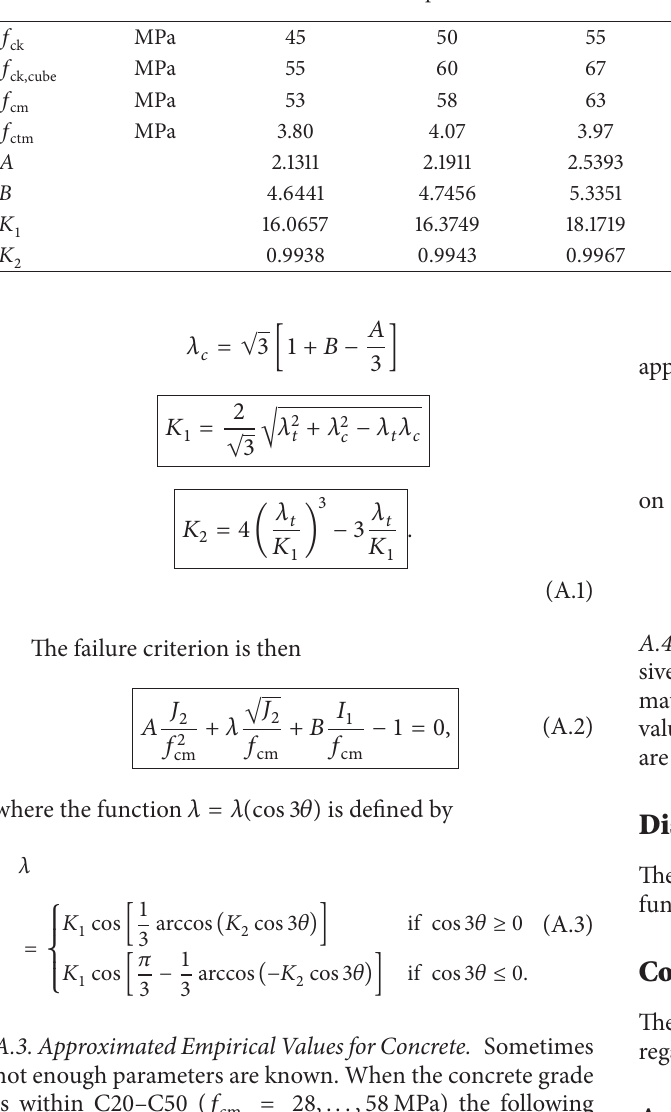
Table 9: Ottosen parameters for Eurocode concrete strength classes